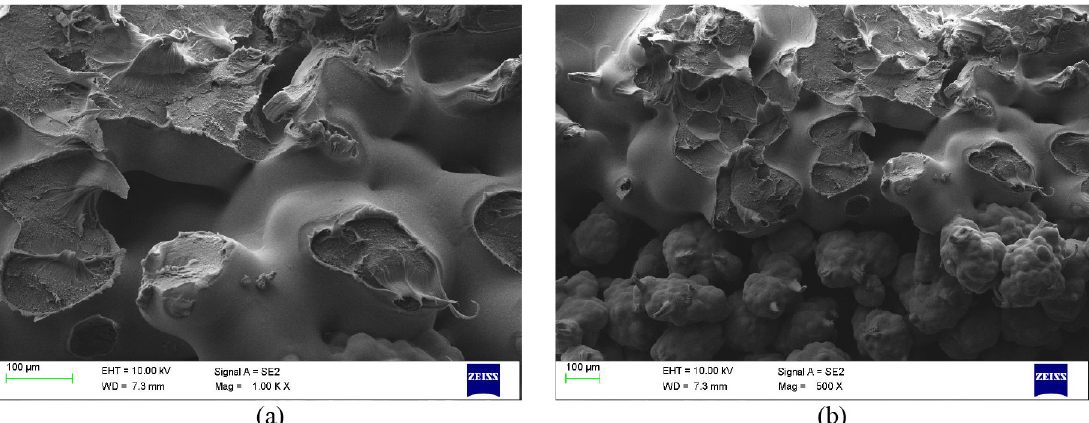
Fig. 15. SEM images of SIS parts fabricated at heater temperature of 220 ° C, heater feed rate of 3 mm/s, and printer feed rate of 100 mm/min. (a) Layer thickness of 0.2mm. (b) Layer thickness of 0.4 mm.